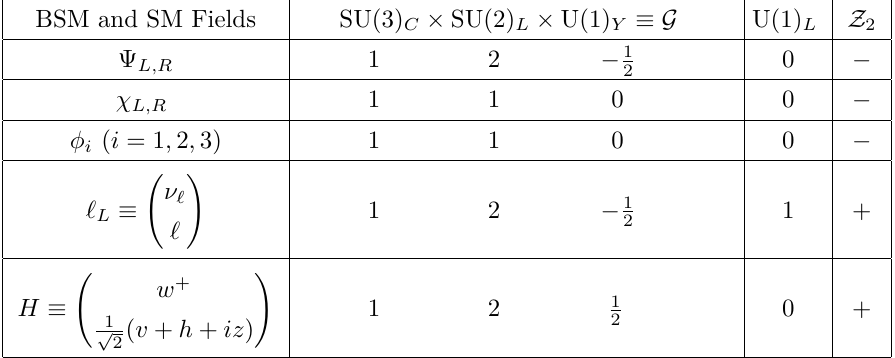
Table 1 . Fields and their quantum numbers under the SM gauge symmetry, lepton number and additional Z 2